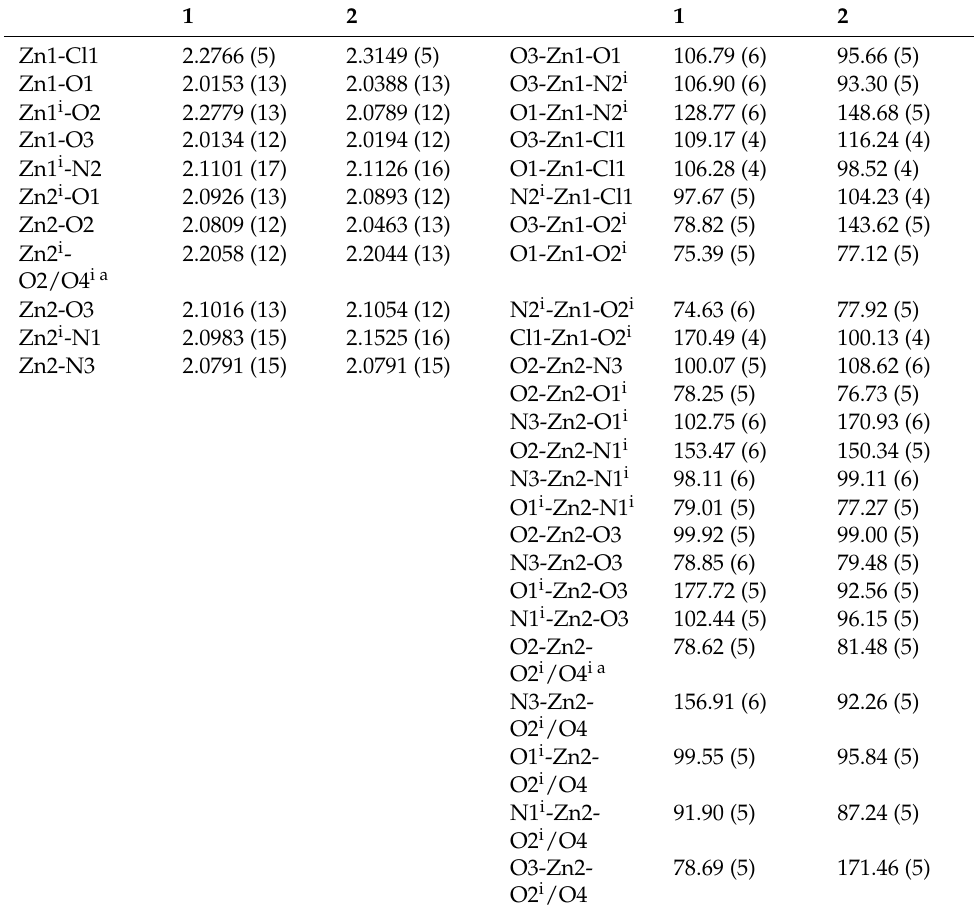
Table 2. Selected bond distances and angles [Å, ◦ ] for 1 and 2 .